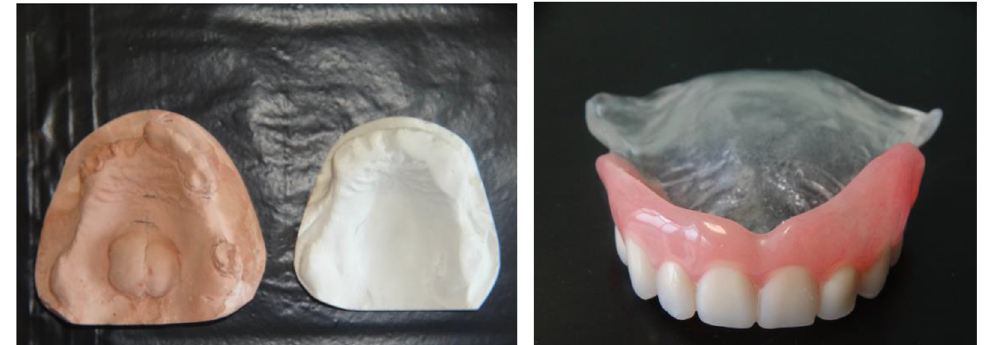
Fig. 5. (a) Initial study model (left) and after simulation of surgical resection with dental avulsions (right). (b) Immediate transient maxillary completely removable prosthesis.